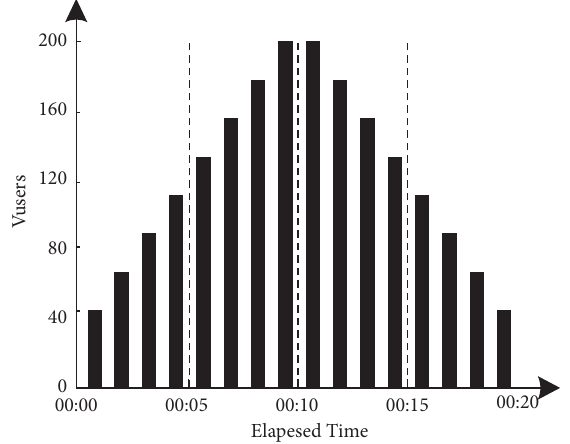
Figure 7: Pressure curve of platform